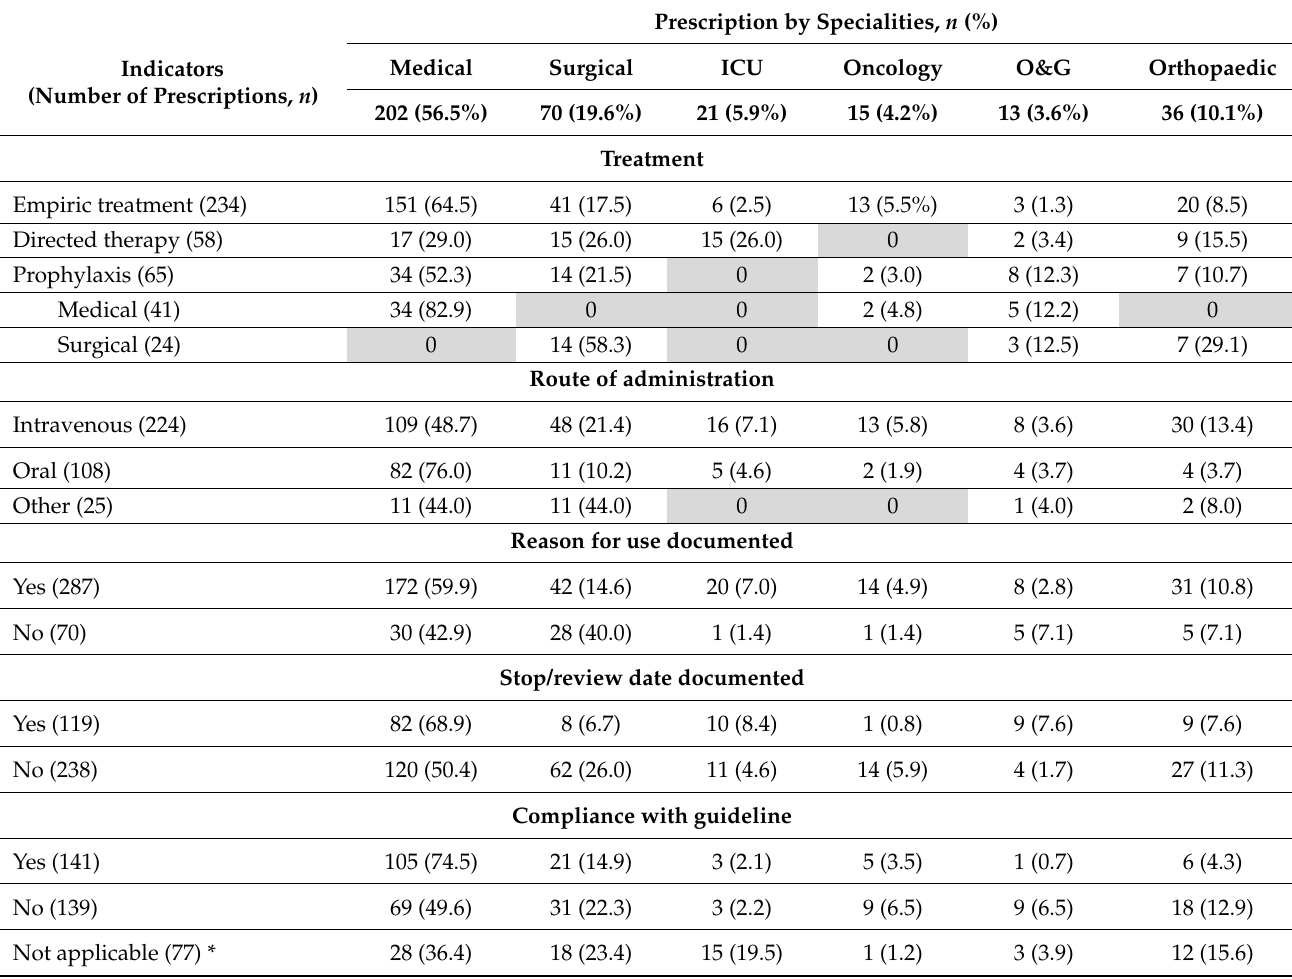
Table 2. Quality indicators for antimicrobial prescriptions ( n =